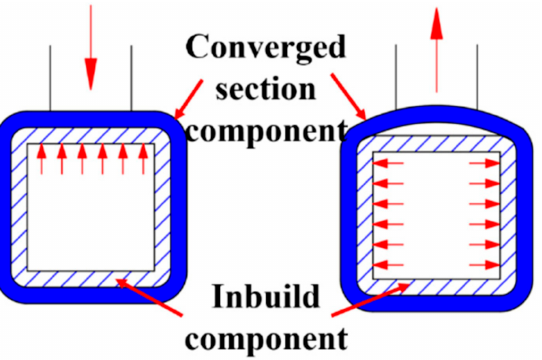
Figure 37. The potentiation mechanism of inbuild component to section